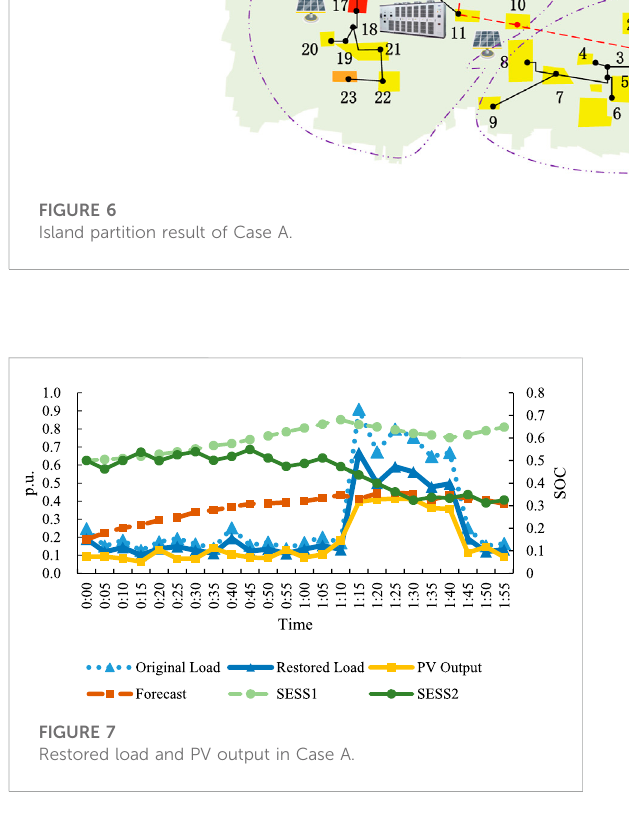
Figure 11. The restored load, PV output, and SOC of